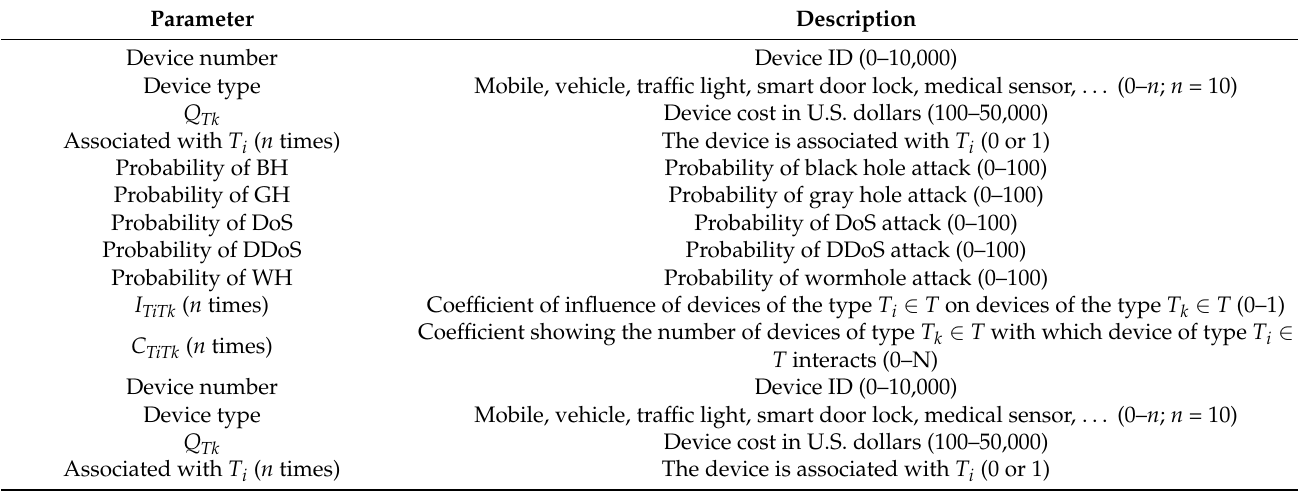
Table 1. Neural network input